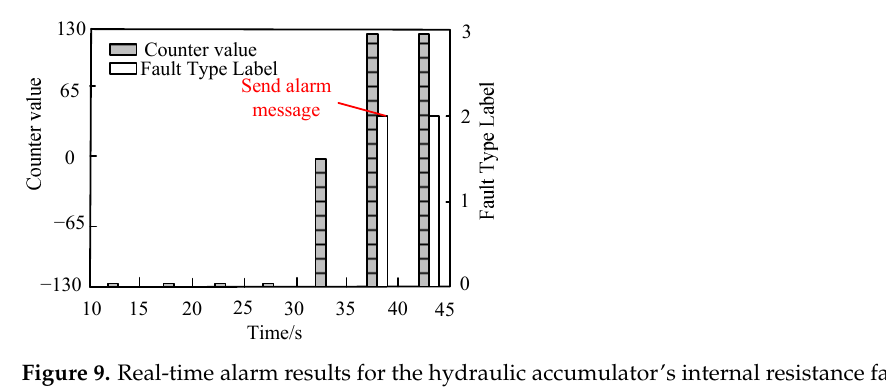
Figure 9. Real-time alarm results for the hydraulic accumulator’s internal resistance failure by the proposed method.